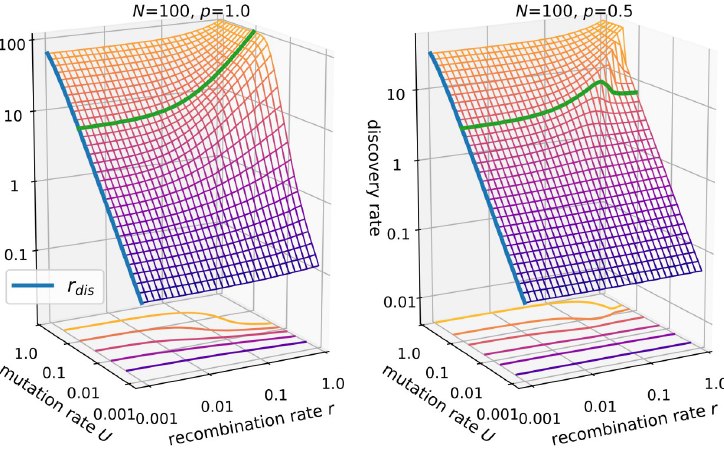
Fig 2. Discovery rate in the ism . The population size is N = 100 with either p = 1.0 (left panel) vs. p = 0.5 (right panel). The green line at U = 0.1 highlights the different effects of recombination in the absence ( p = 1) and presence ( p = 0.5) of lethal genotypes. The blue lines in both panels show Eq